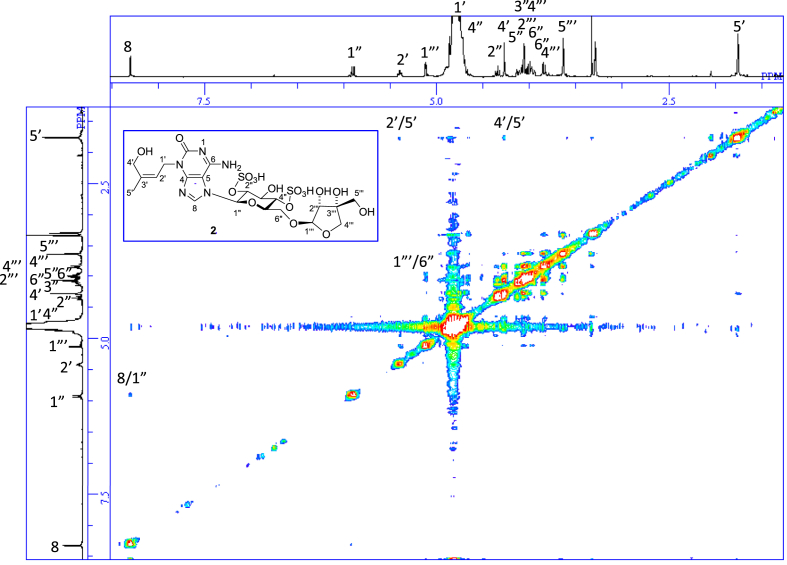
1H–1H NOESY of 2.